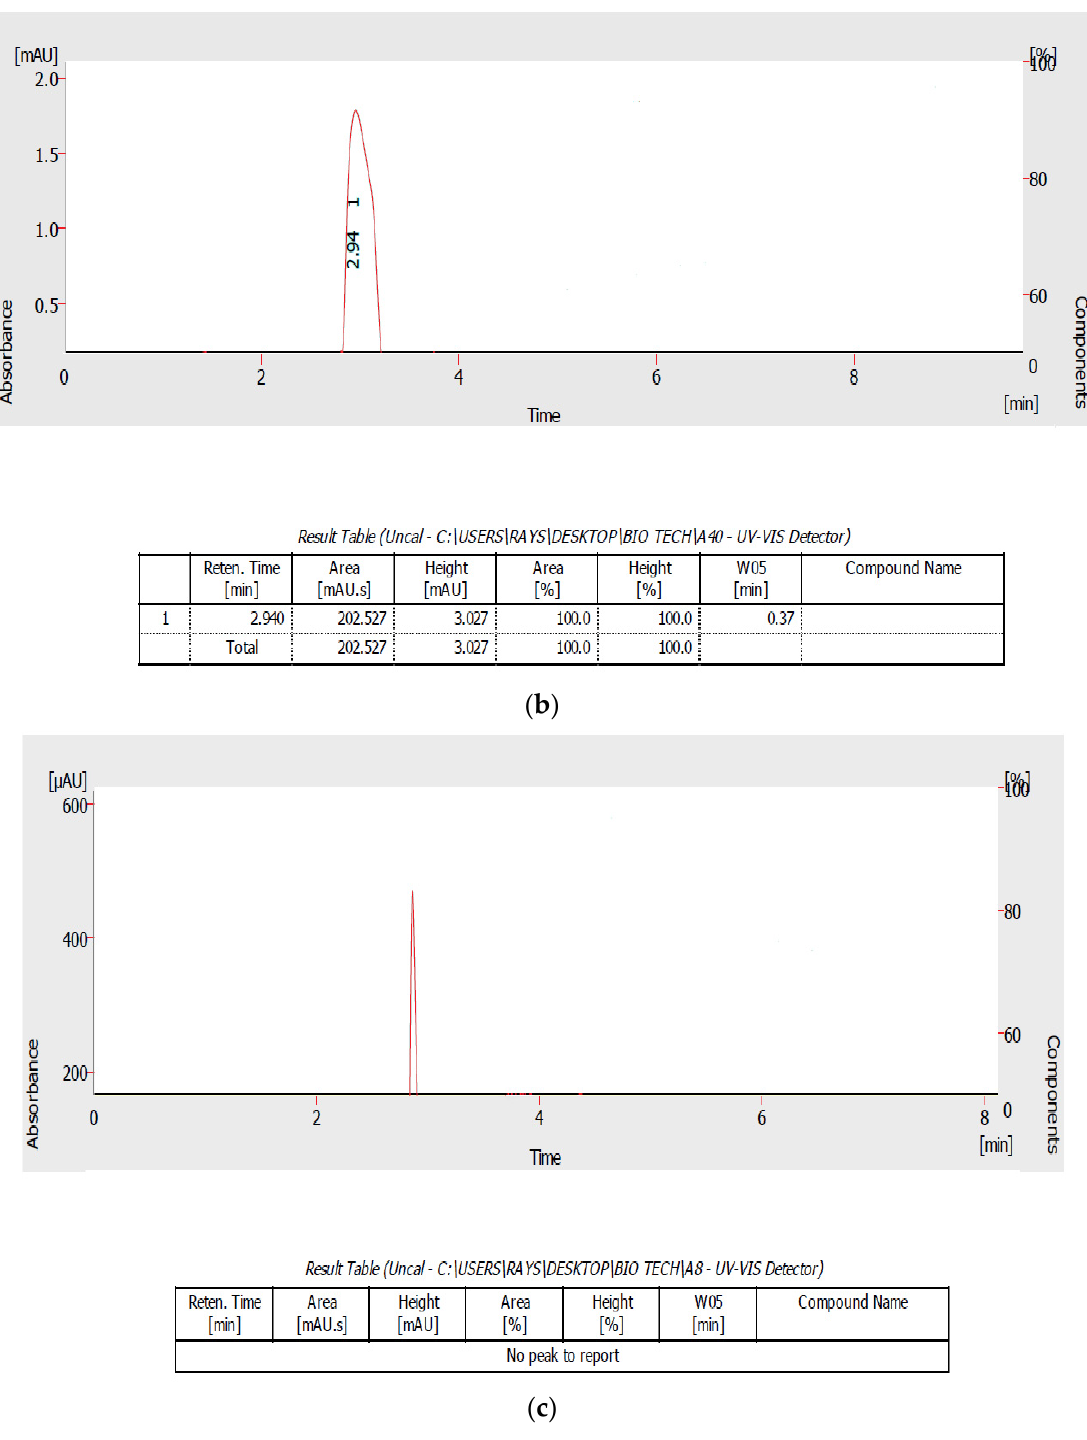
Figure 6. ( a ) Remazol brilliant blue control. ( b ) HPLC profile of RBB (RBBR) degradation by A. terreus. ( c ) HPLC profile of RBB (RBBR) degradation by A. fumigatus.